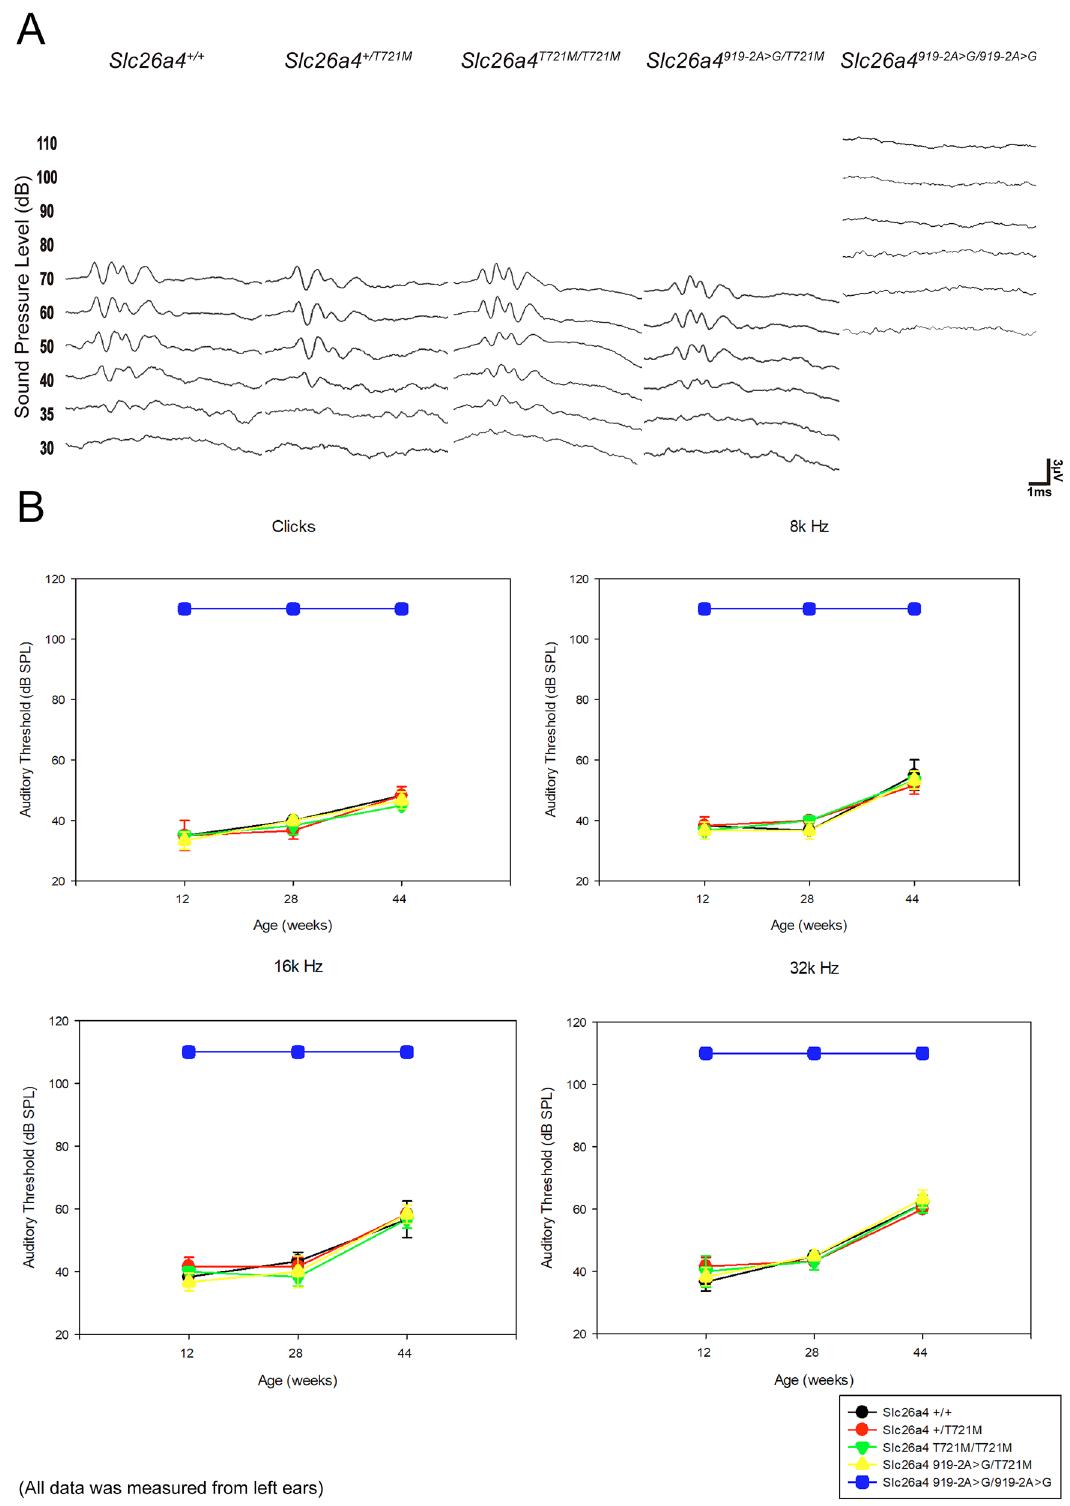
Figure 2. Auditory phenotypes. ( A ) The ABR waveforms in clicks did not differ significantly among heterozygous Slc26a4 + /T721M , homozygous Slc26a4 T721M/T721M , compound heterozygous Slc26a4 919-2A > G/T721M , and wild-type Slc26a4 + / + mice. The ABR waveforms of Slc26a4 919-2A > G/919-2A > G mice with profound hearing loss were also determined for comparison. ( B ) Heterozygous, homozygous, and compound heterozygous mice showed normal hearing thresholds across different frequencies, similar to those in wild-type Slc26a4 + / + mice. There were no significant differences among these four groups of mice at 12, 28, and 44